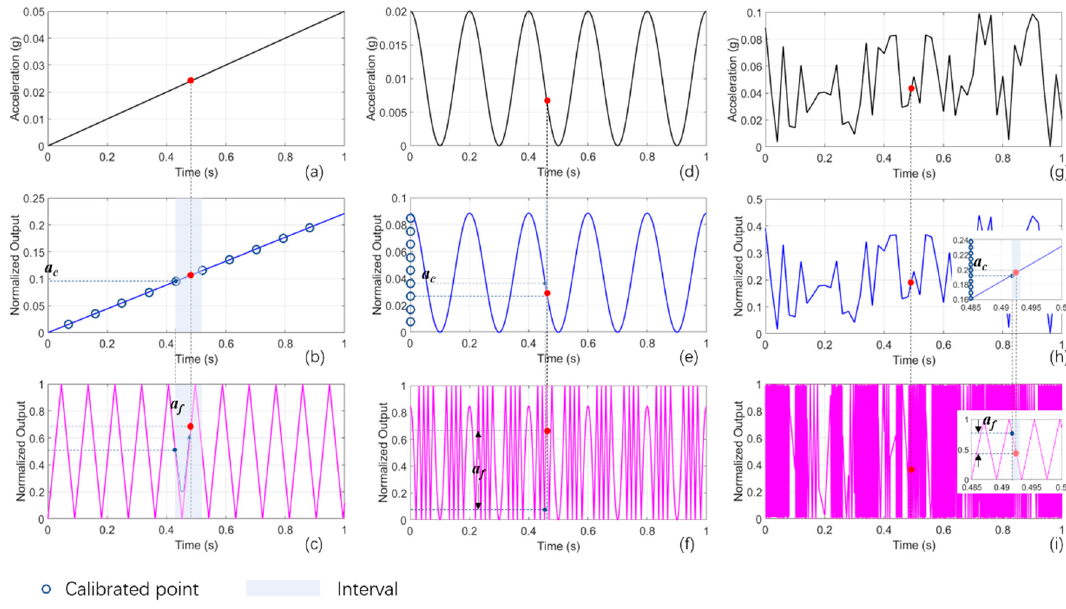
Figure 3. Simulation results for three types of acceleration. ( a ) Acceleration varies with time linearly from 0 to 1 s, and amplitude from 0 to 0.05 g. ( b ) Normalized phase ouput of synthetic wavelength for linear acceleration. ( c ) Normalized phase output of single wavelength for linear acceleration. ( d ) Acceleration with a cosine relationship of time; amplitude is 0.01 g. ( e ) Normalized phase output of synthetic wavelength for cosinoidal acceleration. ( f ) Normalized phase output of single wavelength for cosinoidal acceleration. ( g ) Stochastically varying acceleration as a function of time. ( h ) Normalized phase output of synthetic wavelength for random acceleration; inset: enlarged view of response from 0.485 to 0.5 s. ( i ) Normalized phase output of single wavelength for random acceleration; inset: enlarged view of response from 0.485 to 0.5 s.